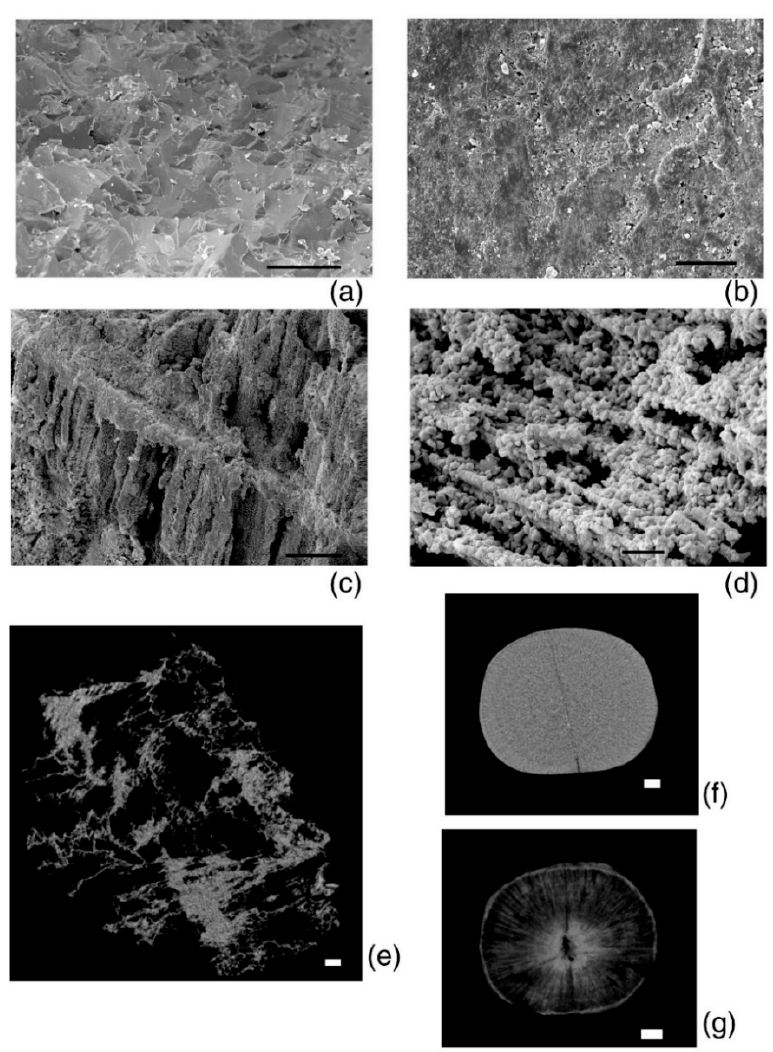
Figure 10. Surface and internal microstructure of belemnite rosters (Upper Jurassic, Upper Volgian; Moscow, Kuntsevo–Filyevsky Park) substituted and unsubstituted with iron minerals: ( a ) transverse split of belemnite rostra not substituted with iron minerals, scale is 100 μ m; ( b ) surface of belemnite rostra not substituted with iron minerals, scale is 30 μ m; ( c , d ) microstructure of the rostrum substituted with iron minerals, scales are 100 and 10 μ m, respectively; ( e ) virtual section of a growth fragment substituted with iron minerals, X-ray microtomography, almost all calcite structures are destroyed inside, scale is 100 μ m; ( f ) transverse virtual section of a belemnite roster not substituted with iron minerals, X-ray microtomography, scale is 1 mm; ( g ) transverse virtual section of the belemnite rostrum substituted with iron minerals, X-ray microtomography, scale is 1 mm.